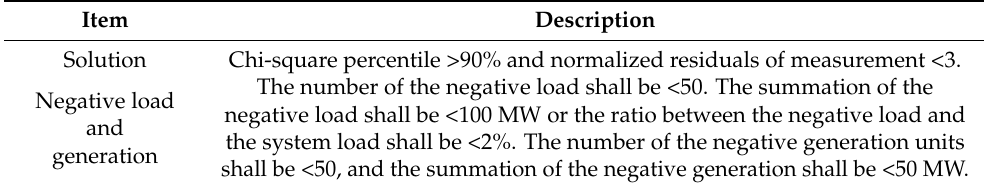
Table 17. State estimation performance requirements of CASIO [27].